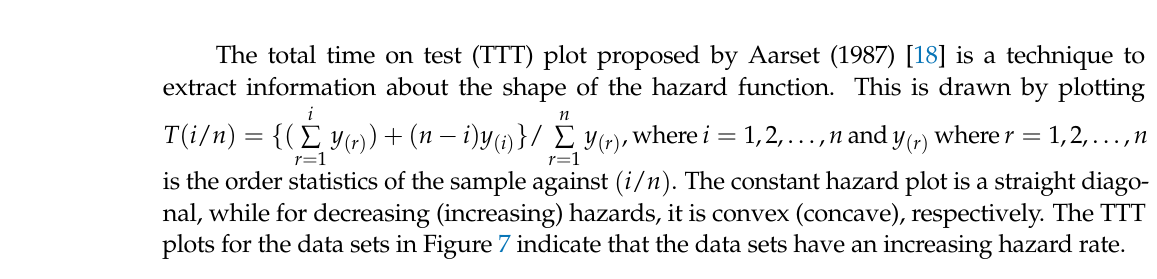
Table 2. Descriptive Statistics for the data set I and data set II.